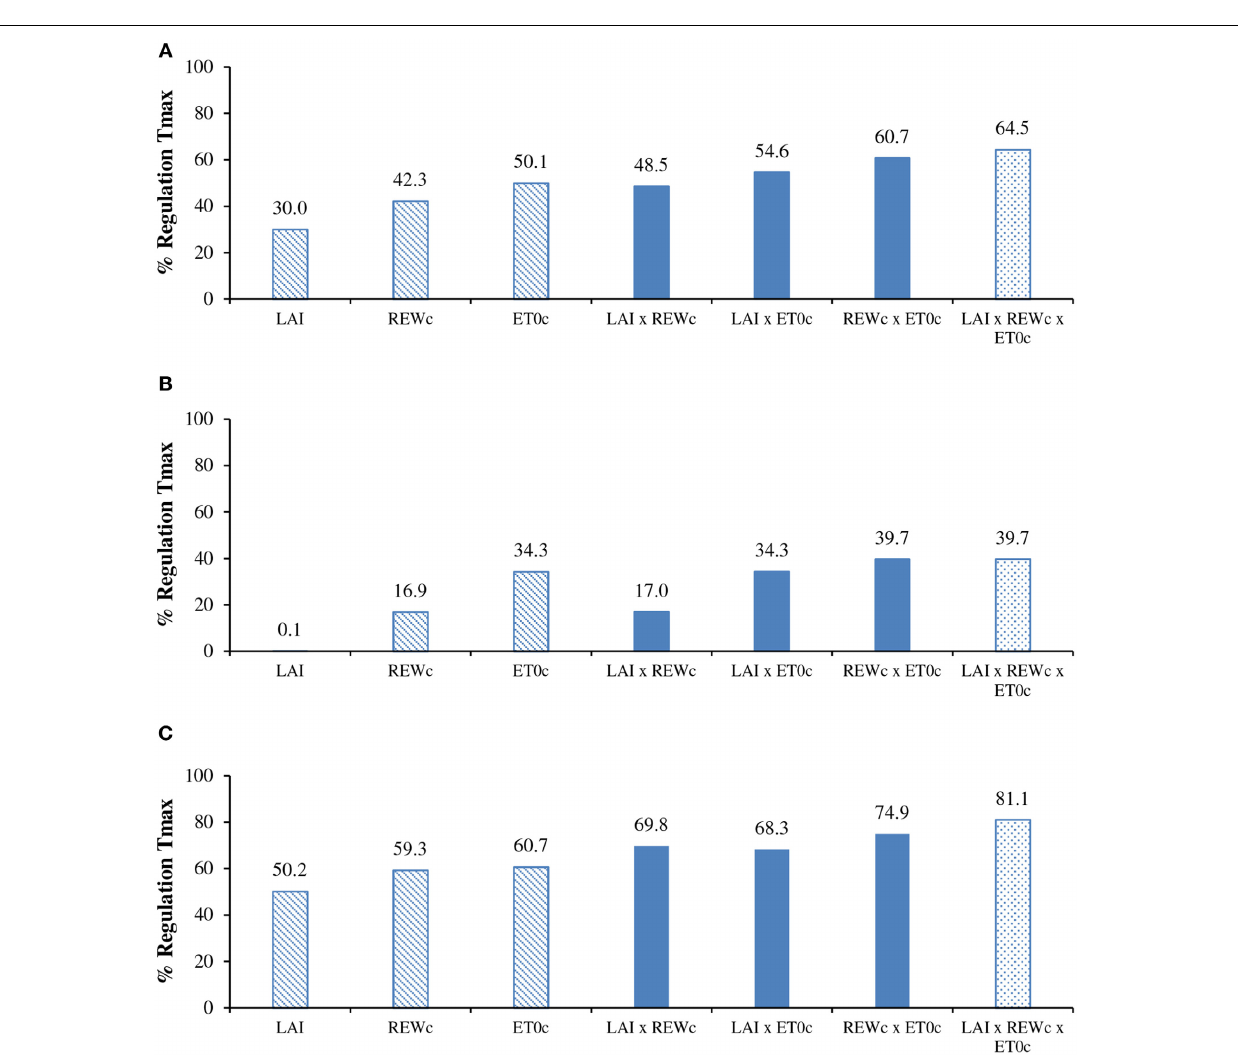
change, critical relative extractable water ( REWc ) and critical potential evapotranspiration ( ET0c ). For details of simulation see paragraphs Modeling and Simulation of